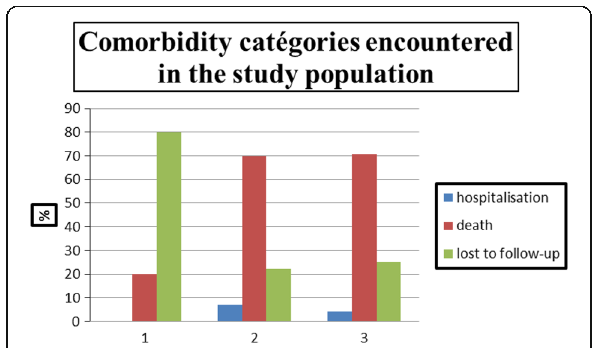
Fig. 2 Comorbidity categories encountered in the study population. 1 oncological disease (onco) + renal failure (RF) + cardiovascular disease (CVD), 2 AIDS + CVD + chronic respiratory disease, 3 RF + diabetes +